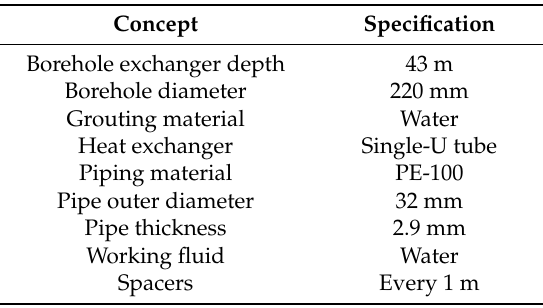
Table 1. Characteristics of the borehole system.